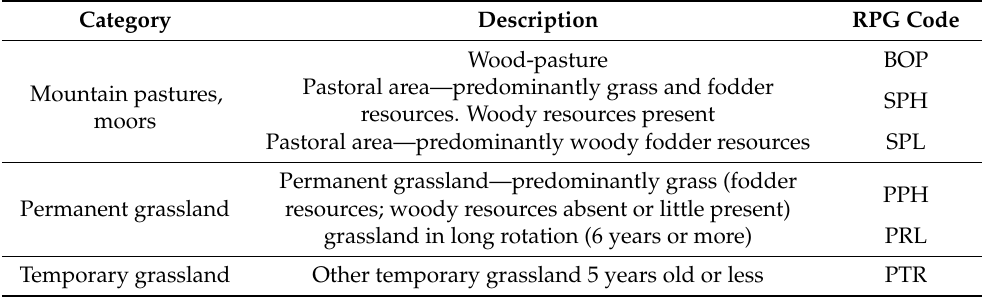
Table 1. Selected RPG categories of land use for beef feeding. Category Mountain pastures,